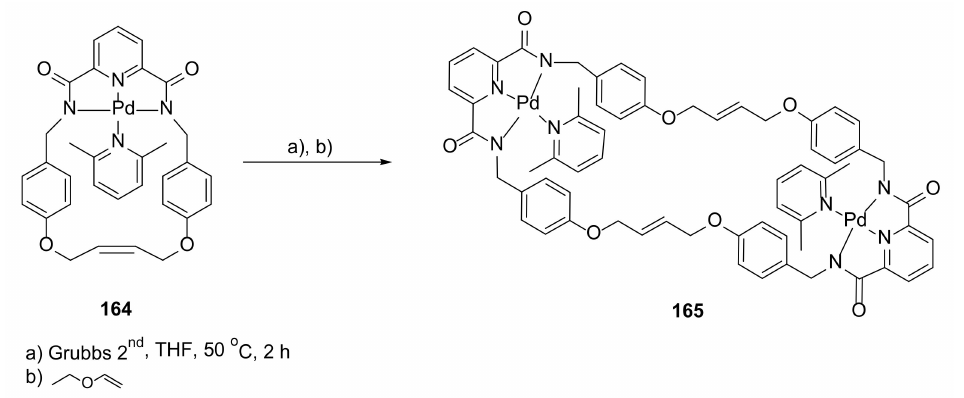
Figure 34. Ligand-driven ring expansion by metathesis